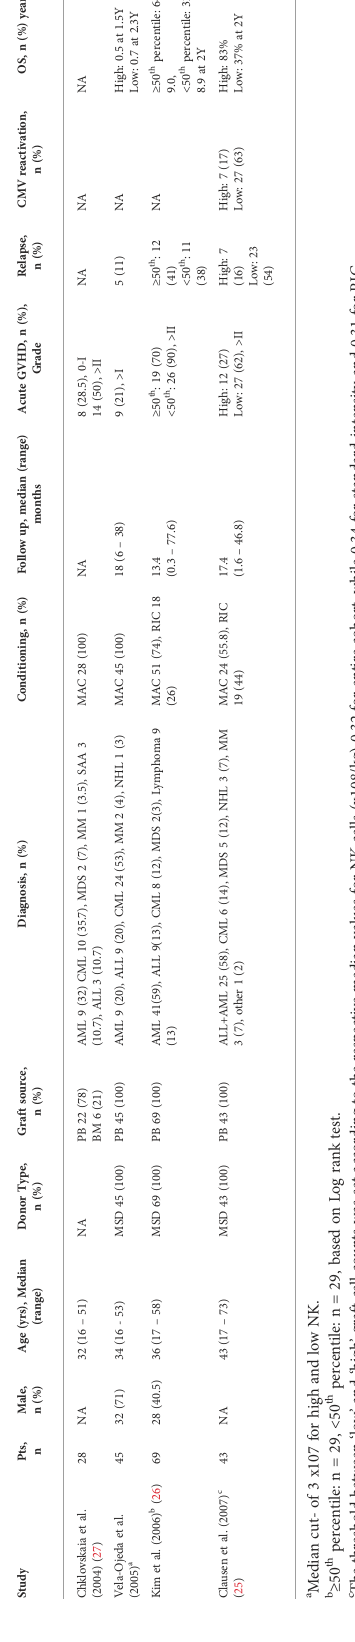
male. The median duration of follow-up was 23.1 (8-81.6) months. All four studies used haplo donors. RIC was used in 70% (54/77) of the patients and MAC was used in 27% (21/77) of the patients. The hematologic diagnoses were ALL 15.5% (12/ 77), AML 67.5% (52/77), lymphoma 3.8% (3/77), MDS 2.6% (2/ 77), CML 7.7% (6/77), and sarcoma 1% (1/77). All four studies used donor-derived NK cells. PBMCs were collected by apheresis followed by CD3+ depletion and CD56+ selection Ciuera et al. also performed ex vivo expansion as detailed in Table 4. Patients received 2-3 NK cell infusions. NK cell infusion doses ranged from 1 x10 (5) cells/kg to 1 x10 (8) cells/kg (33 – 36). At the median follow-up of 1 (0.63-5) year, the pooled OS was 69% (95% CI 0.38-0.93, I 2 = 63%, n=34) (33, 34, 36). The pooled ORR was 77% (95% CI 0.55-0.94, I 2 = 0, n=21) (33, 34). The pooled CR was 42% (95% CI 0.08-0.79, I 2 = 84%, n=62) (33 – 35). The pooled RR was 28% (95% CI 0.13-0.46, I 2 = 47%, n=24) (33 – 36). The pooled incidence of acute and chronic GVHD